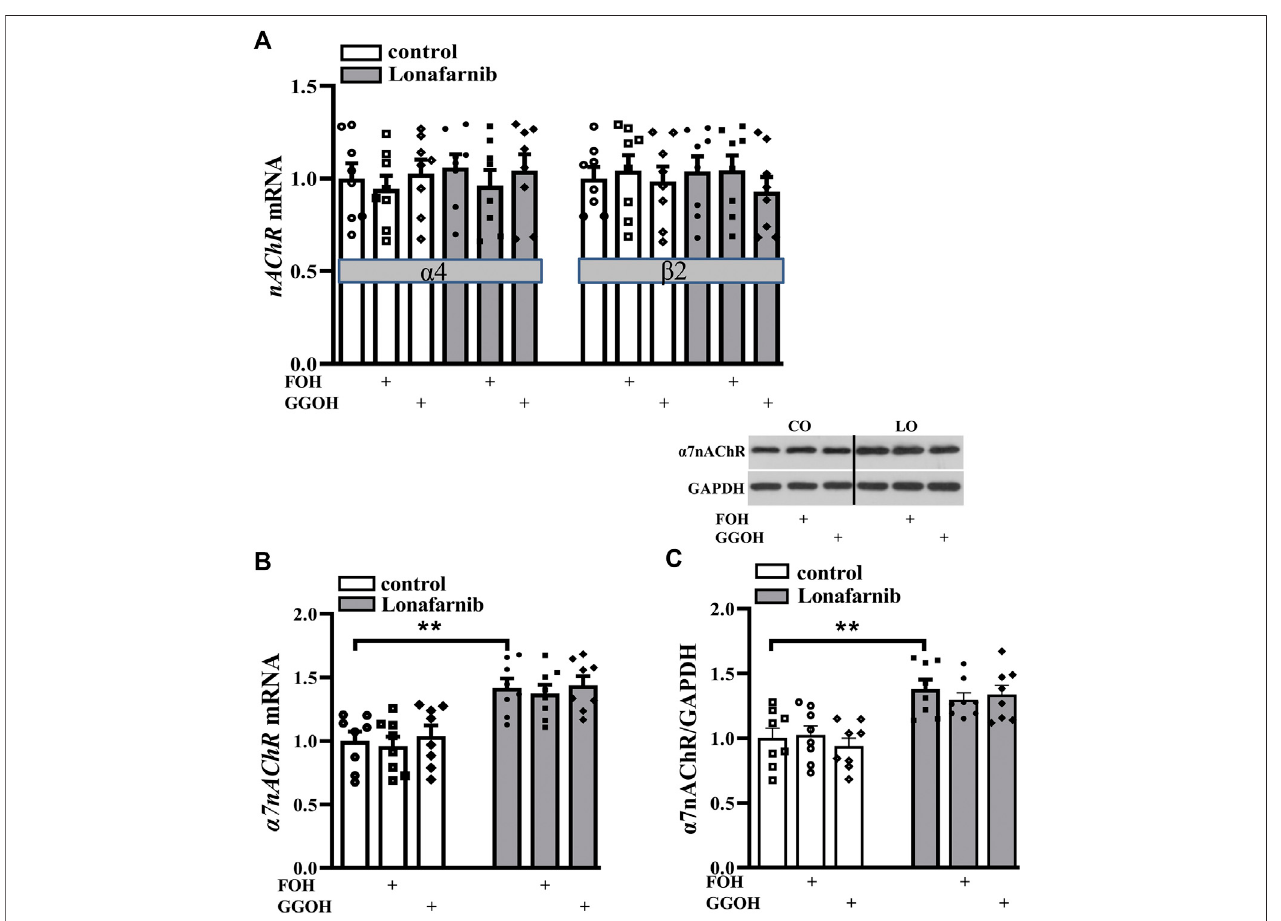
FIGURE 2 | Lonafarnib administration increases the expression of hippocampal α 7nAChR, but not α 4/ β 2nAChR. (A) Levels of α 4/ β 2nAChR mRNA in the hippocampus of control mice and lonafarnib-treated mice administrated with vehicle, FOH, or GGOH. (B) Level of α 7nAChR mRNA in the hippocampus of control mice and lonafarnib-treated mice treated with vehicle, FOH, or GGOH. ** P < 0.01 vs. control mice (two-way ANOVA, followed by Tukey ’ s multiple comparison test). (C) Level of α 7nAChR protein in the hippocampus. ** P < 0.01 vs. control mice (two-way ANOVA, followed by Tukey ’ s multiple comparison test). CO: control mice, LO: lonafarnib-treated mice. The expression of mRNA and protein were normalized by the values of control group with vehicle.